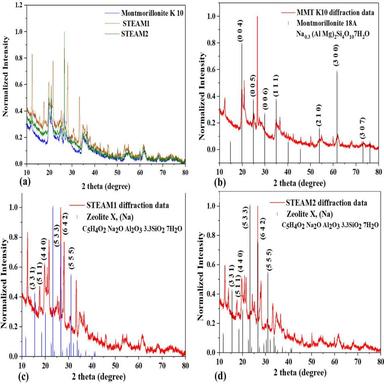
XRD spectra: (a) combined diffraction peaks of MMT K10, STEAM1, and STEAM2; (b) MMT K10 diffraction peaks (c) STEAM1 diffraction peaks; (d) STEAM2 diffraction peaks.